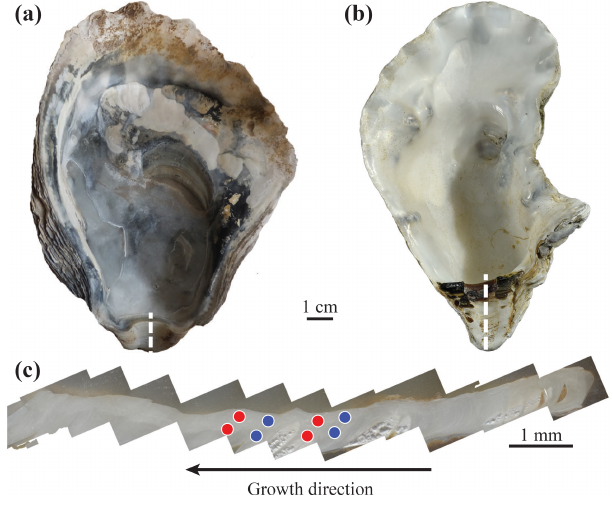
Figure 2. Typical archaeological Ostrea edulis (a) and modern Crassostrea gigas (b) specimens. The umbo region (c) is cut fol- lowing the dashed white line; laser ablation craters (200µm in di- ameter) are indicated by circles. Multiple measurements have been performed on each shell for both winter and summer parts. Red and blue circles represent measurements corresponding to summer and winter periods, respectively, based on